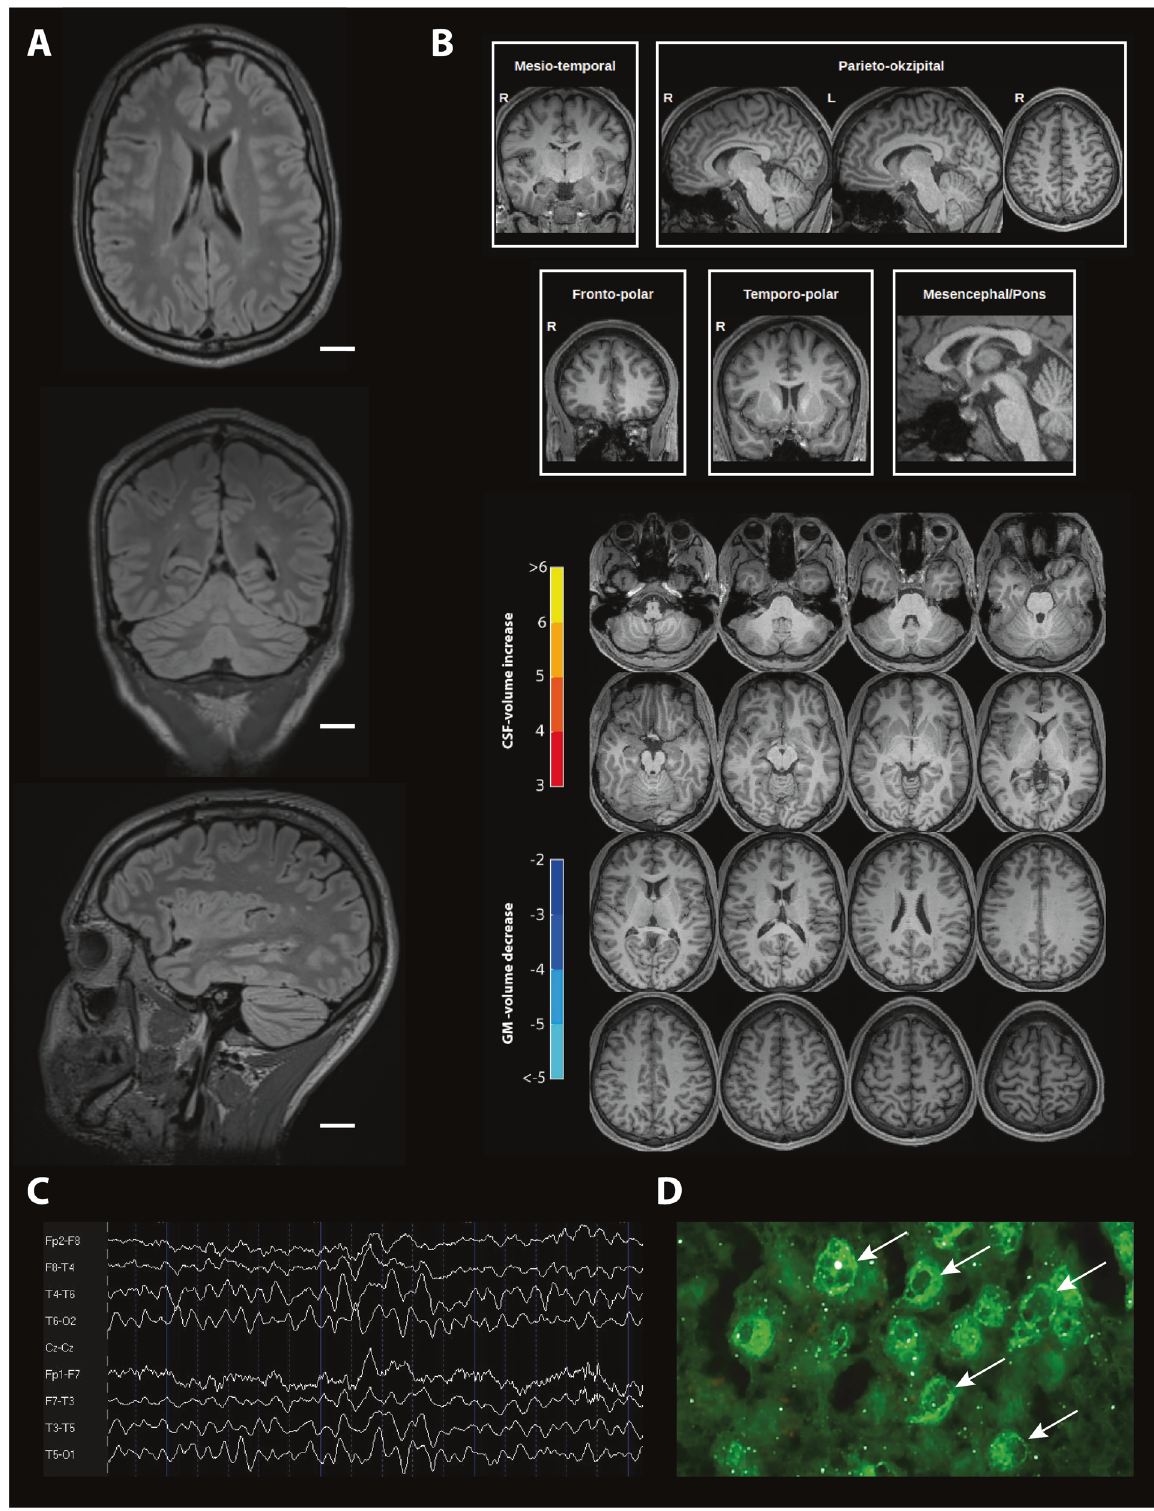
Fig. 3 Exemplary diagnostic fi ndings as may be found in some patients with OCD. A MRI with postin fl ammatory white matter lesions in FLAIR-sequences. B Automated Veobrain MRI analyses of the same patient shows normal fi ndings without atrophic changes C EEG fi nding with intermittent generalized slowing. D Perinuclear staining (which were identi fi ed in serum and cerebrospinal fl uid of some OCD patients) on un fi xed murine brain slices (Prof. Prüß, Charité Berlin). FLAIR Fluid-attenuated inversion recovery, GM gray matter, FDG-PET fl uorodeoxyglucose - positron emission